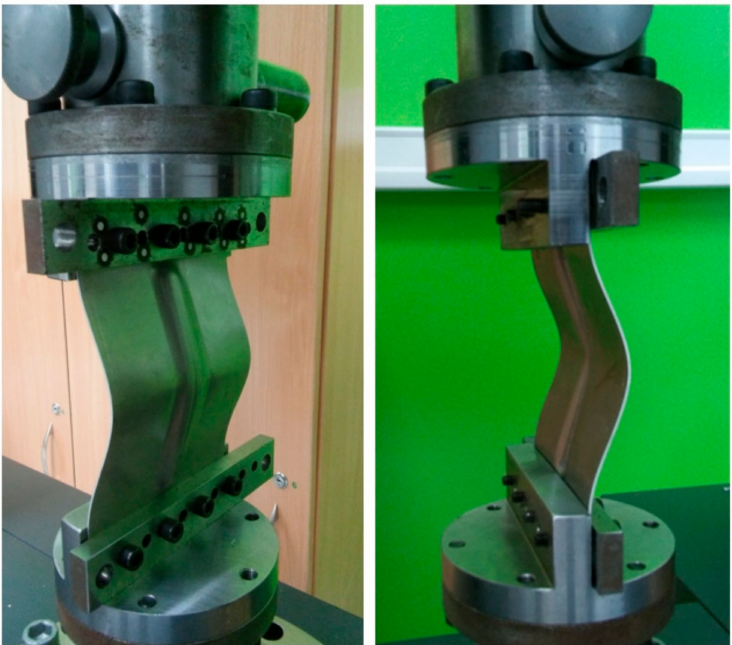
Figure 5. Rib-stiffened panel mounted in the grips of the tensile testing